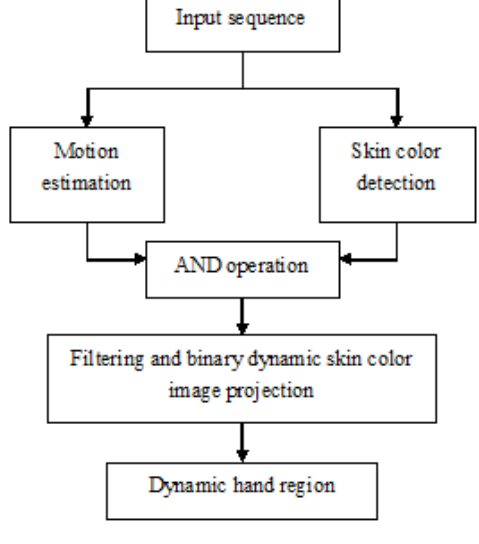
Figure 2. Dynamic hand gesture detection flow